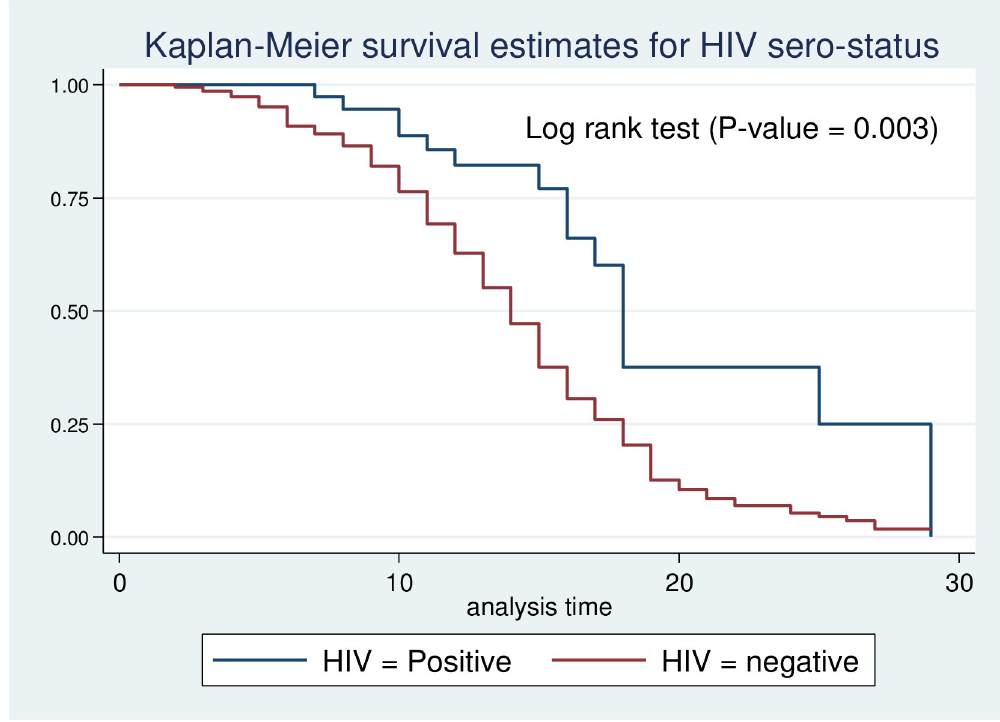
Fig 4. Log-rank survival estimate for time to recovery of SAM children by HIV